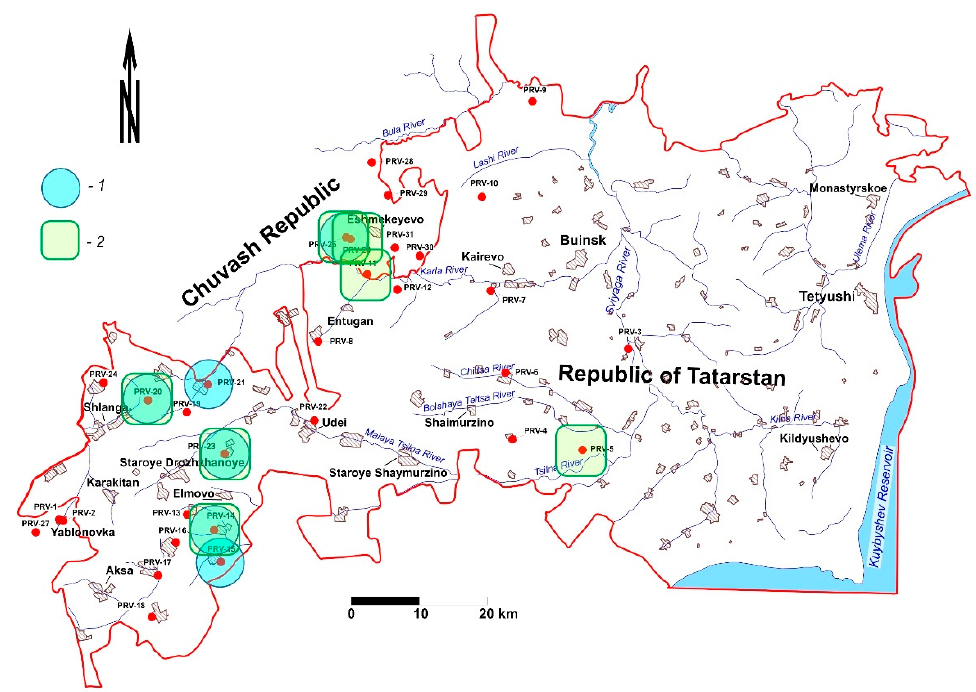
Figure 5. Areas with anomalies in the uranium isotopic composition and hydraulic head: 1 —anomalies of the uranium-234 content ( 234 U/ 238 U > 7.8); 2 —points where the hydraulic head, calculated taking into account the temperature and water salinity, deviates from the regional trend (Figure 6).